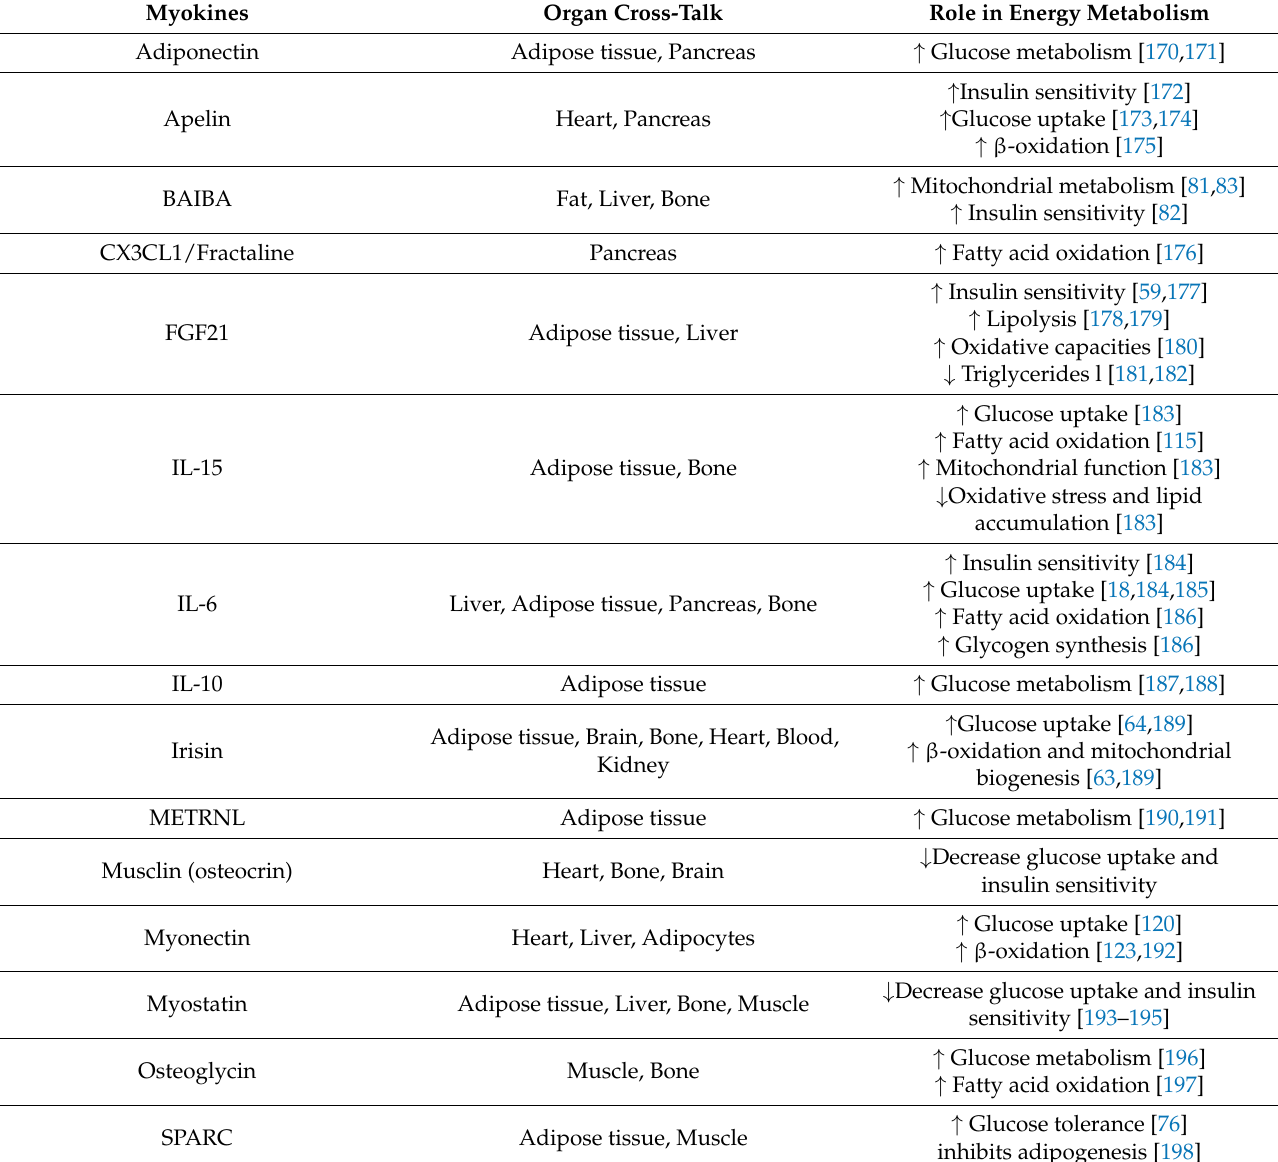
Table 1. Myokines involved in organ cross-talk and regulation of